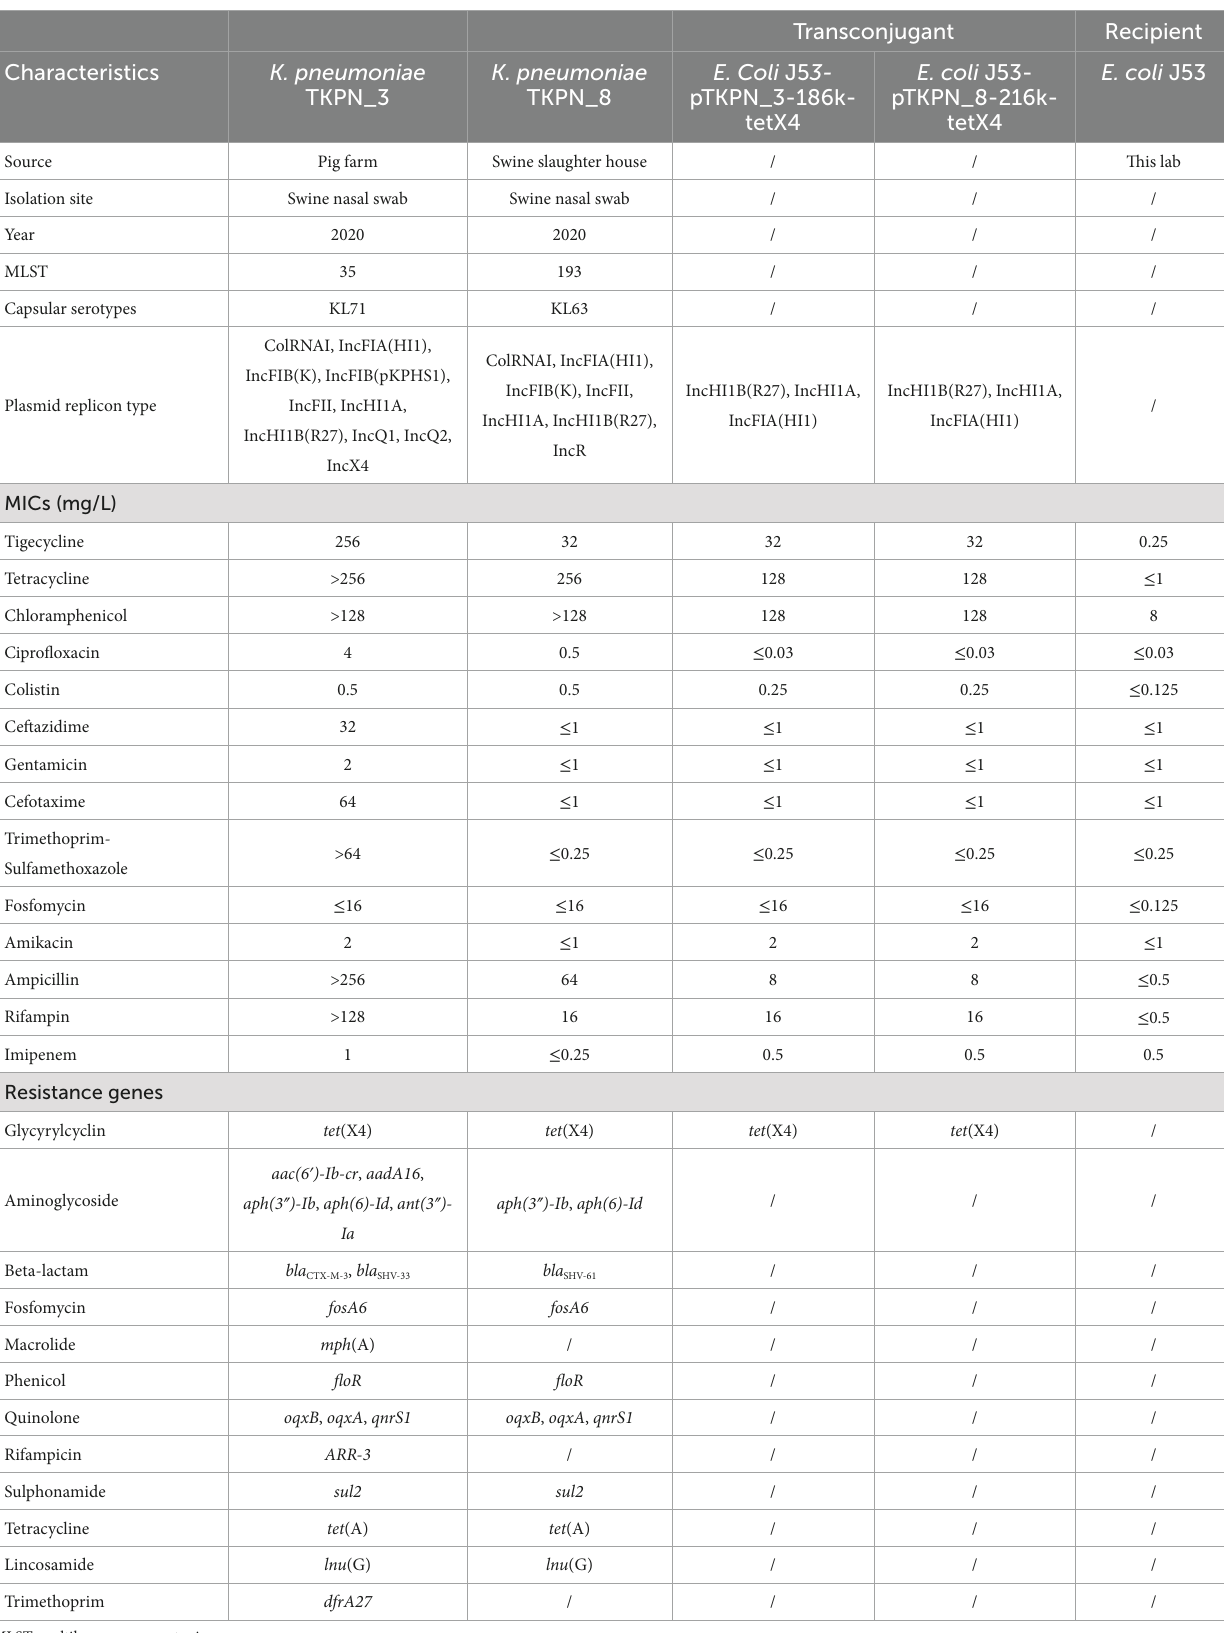
TABLE 1 Characteristics of the two tet (X4)-positive Klebsiella pneumoniae